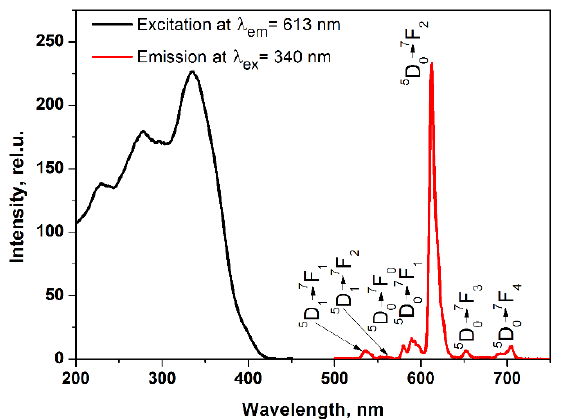
Figure 2. Synthesis of tris( β -diketonate) Eu(III) complexes with 1,10-phenanthroline.